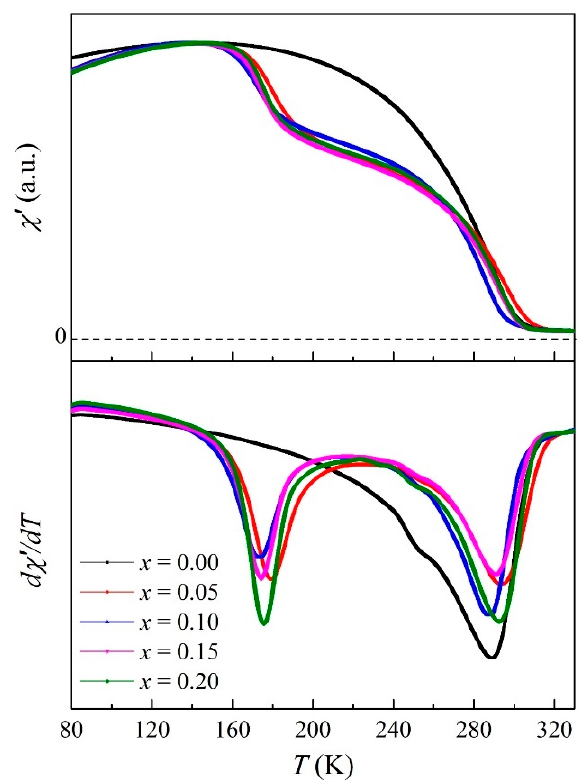
Figure 3. Temperature dependence of AC susceptibility for LCMO:NiO composites.